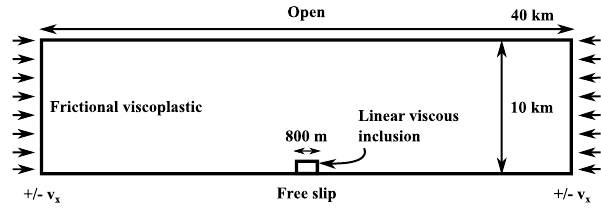
Figure 4. The brick benchmark model setup after Kaus (2010): a rectangular domain with a prescribed inward or outward horizontal component of velocity on the vertical boundaries (the vertical com- ponent is left free). The upper boundary is open, while the bottom boundary is free slip. A small viscous inclusion of 800 × 400m is placed at the bottom of the